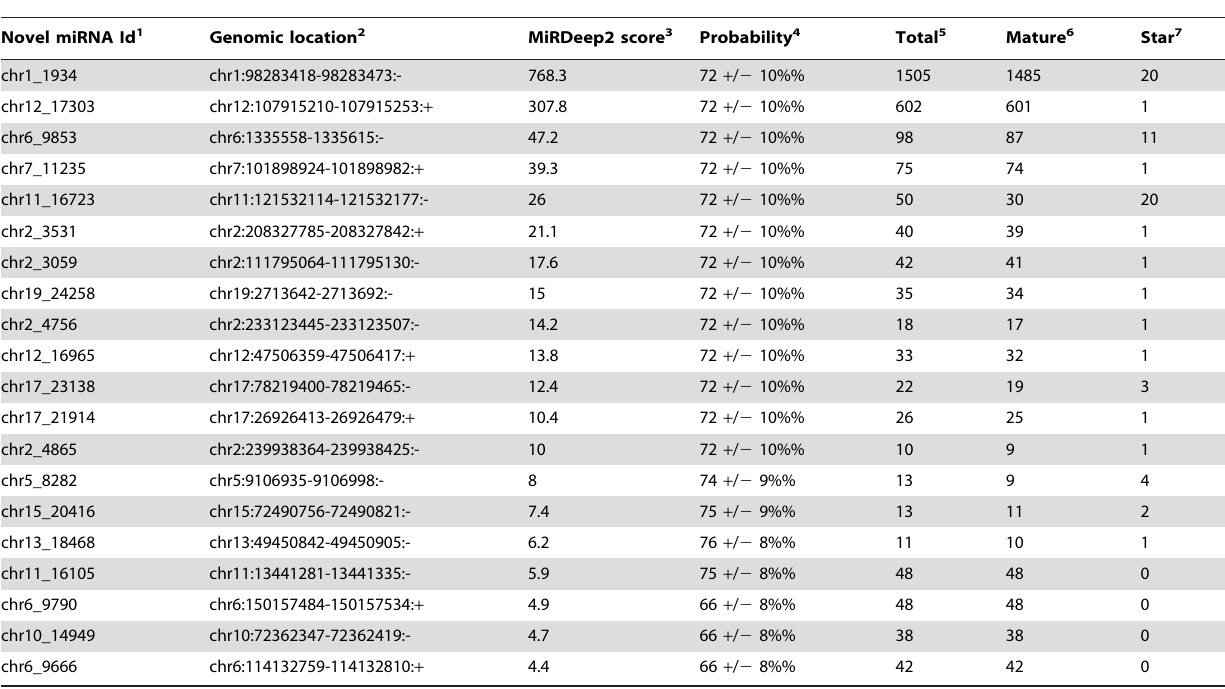
Table 1. Novel miRNAs predicted by miRDeep2 in IMR90 fibroblast data sets.